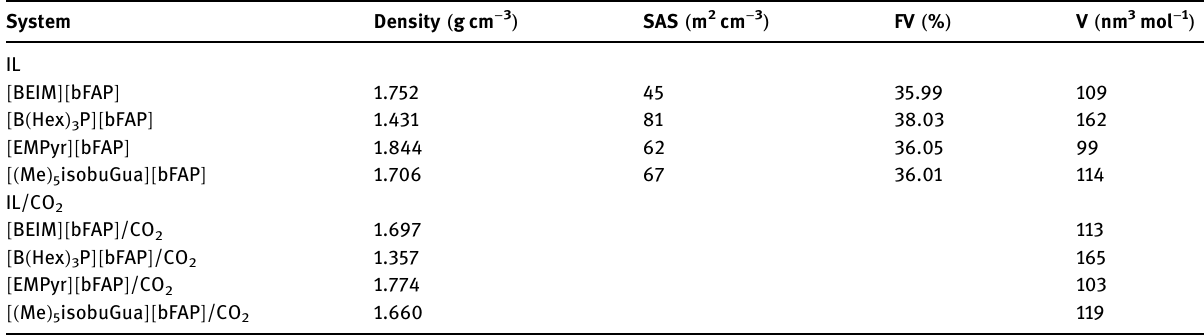
Table 2: Calculated density and other properties for the simulated systems